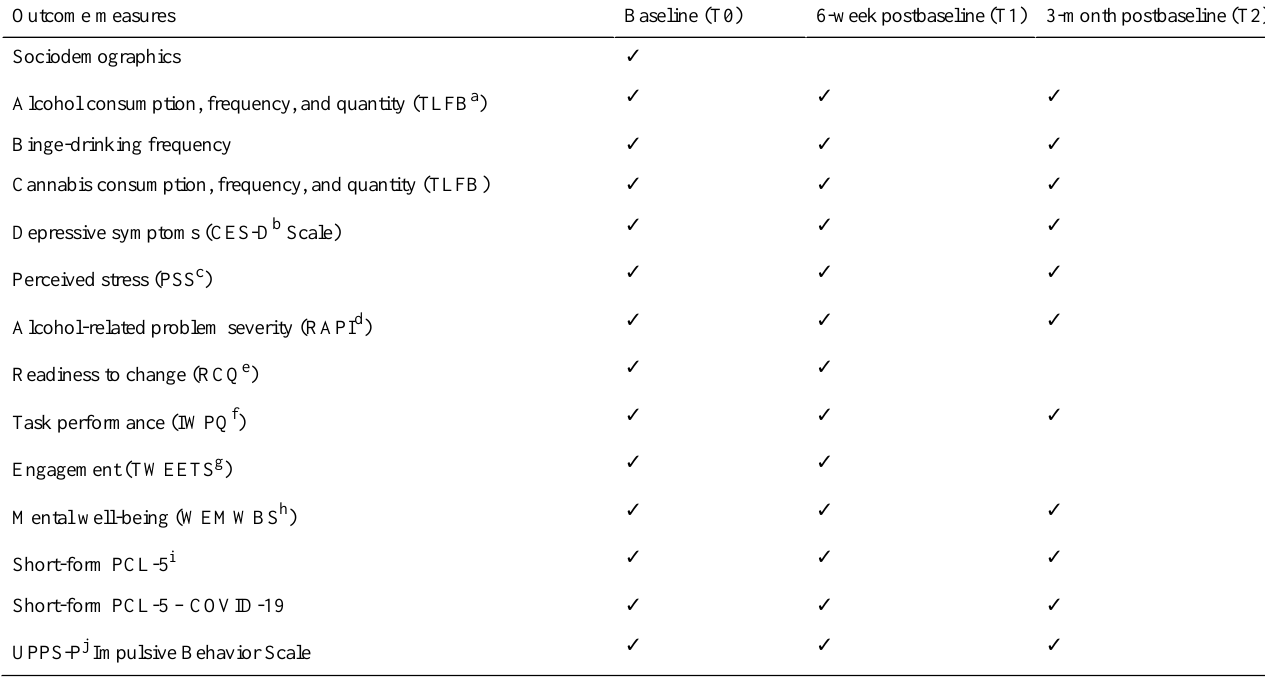
Table 1. Overview of study measurements, timepoints, and